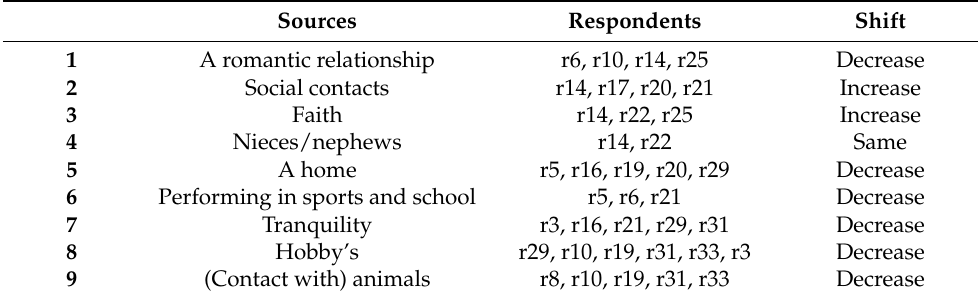
Table 6. Sources of the ‘fulness’ in the post-treatment stories.